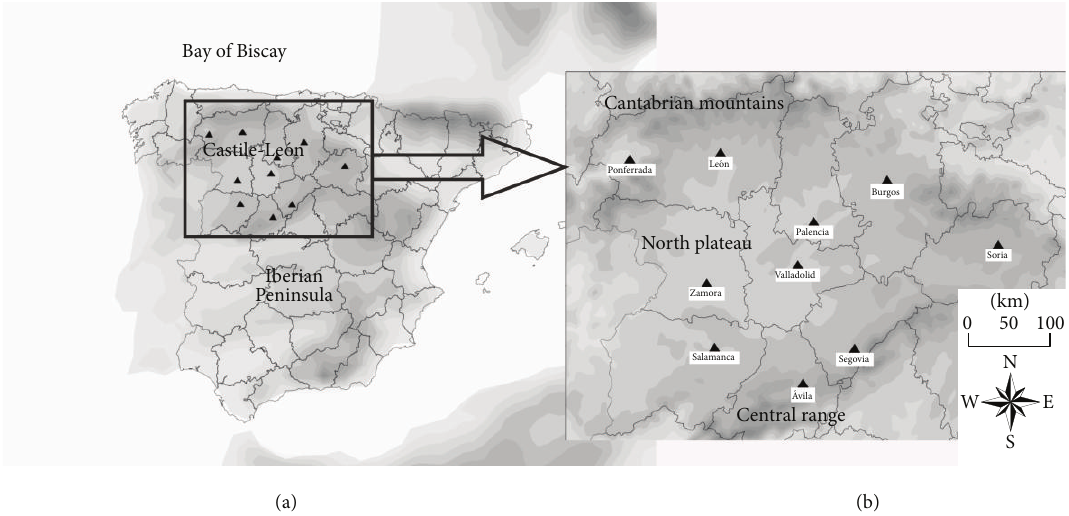
Figure 1: (a) Iberian Peninsula. (b) Study area of Castilla y Le´on and locations of its principal cities.